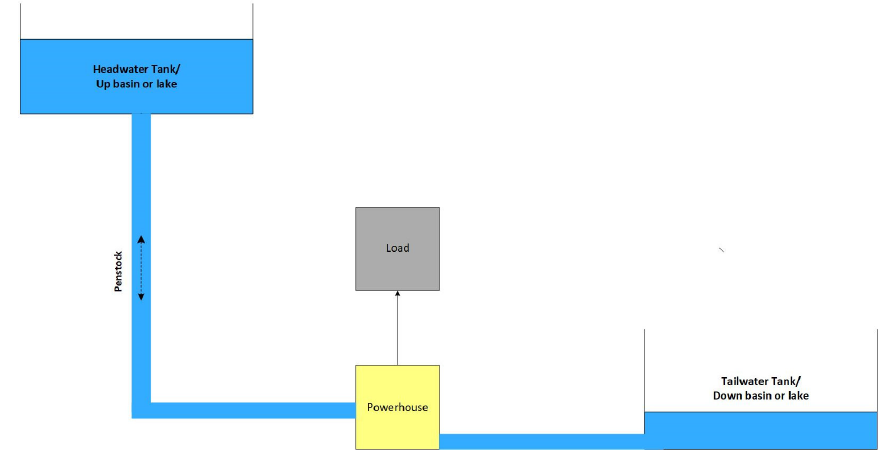
Figure 6. Working principle of pumped hydroelectric storage stations.